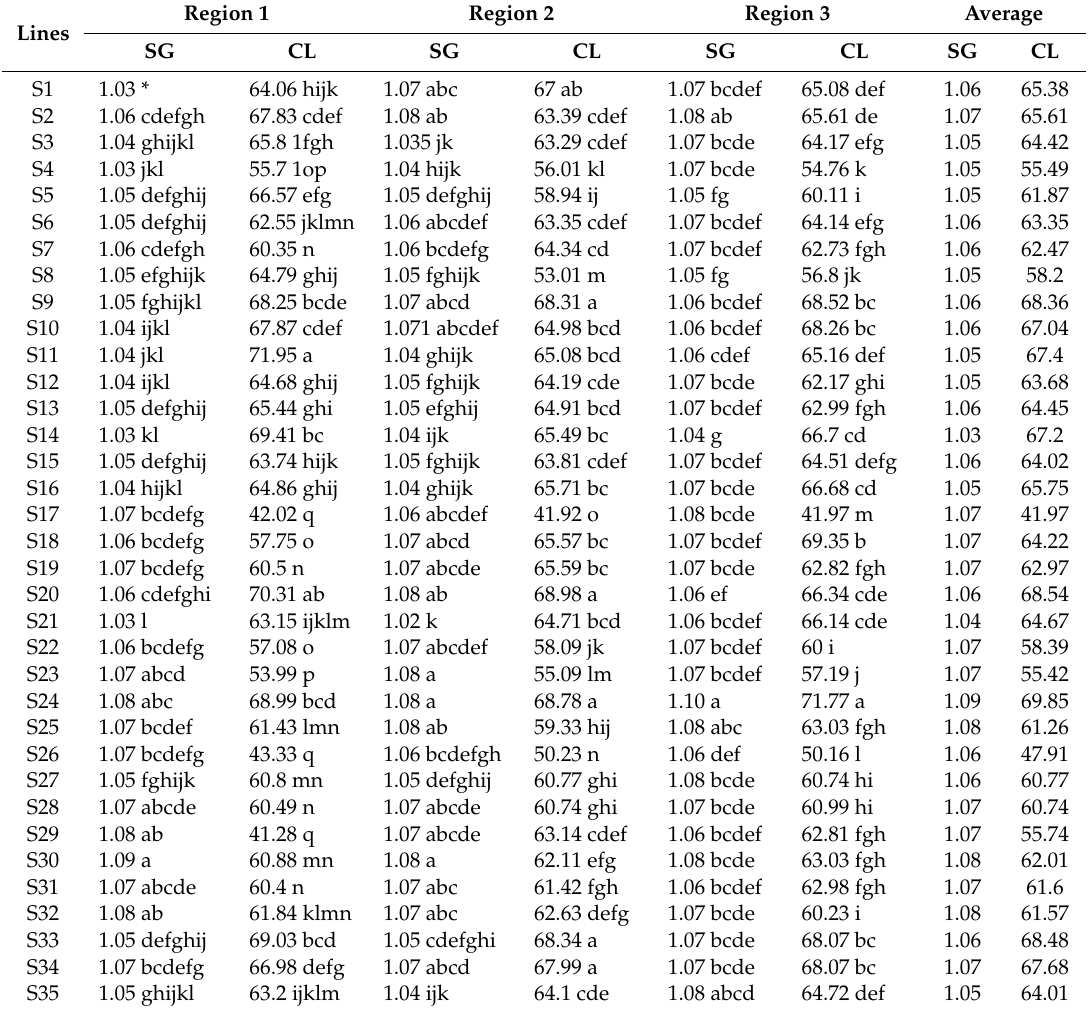
Table 3. Specific gravity (SG) and chip lightness (CL) of 35 potato lines grown in three di ff erent agro-ecological regions in South